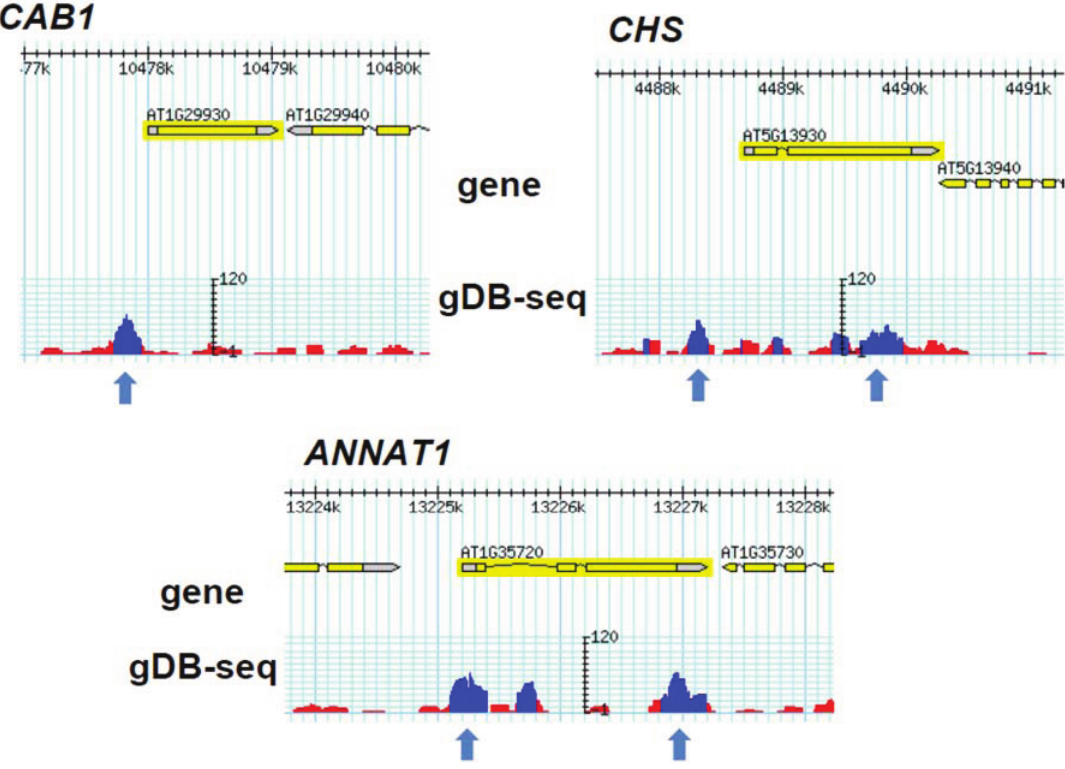
Figure 6. Genome browser view of the CAB1 , CHS and ANNAT1 loci. Arrows indicate possible peak positions, which were not detected in MACS2 (Model-based Analysis of ChIP-Seq) peak prediction.